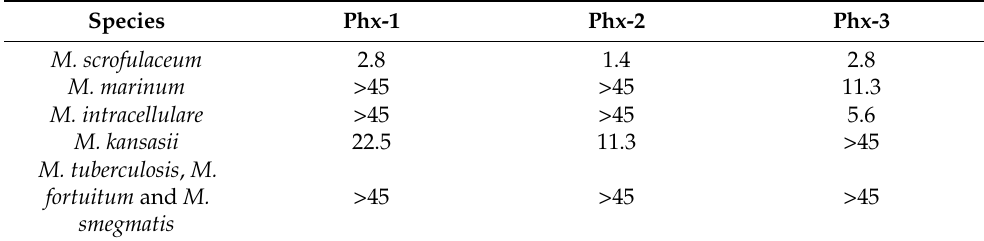
Table 1. Minimum inhibitory concentration values ( µ g/mL) obtained by Shimizu et al. [89] for